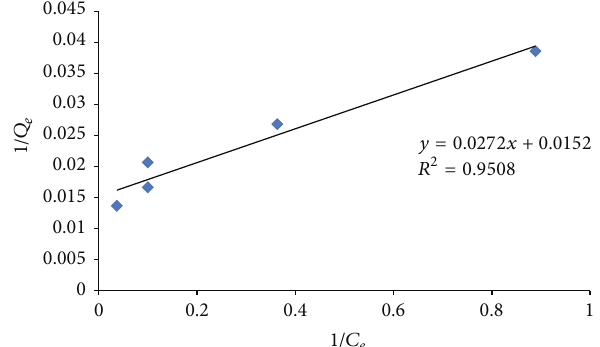
Figure 6: The linear Langmuir adsorption isotherms for BBG dye adsorption by the